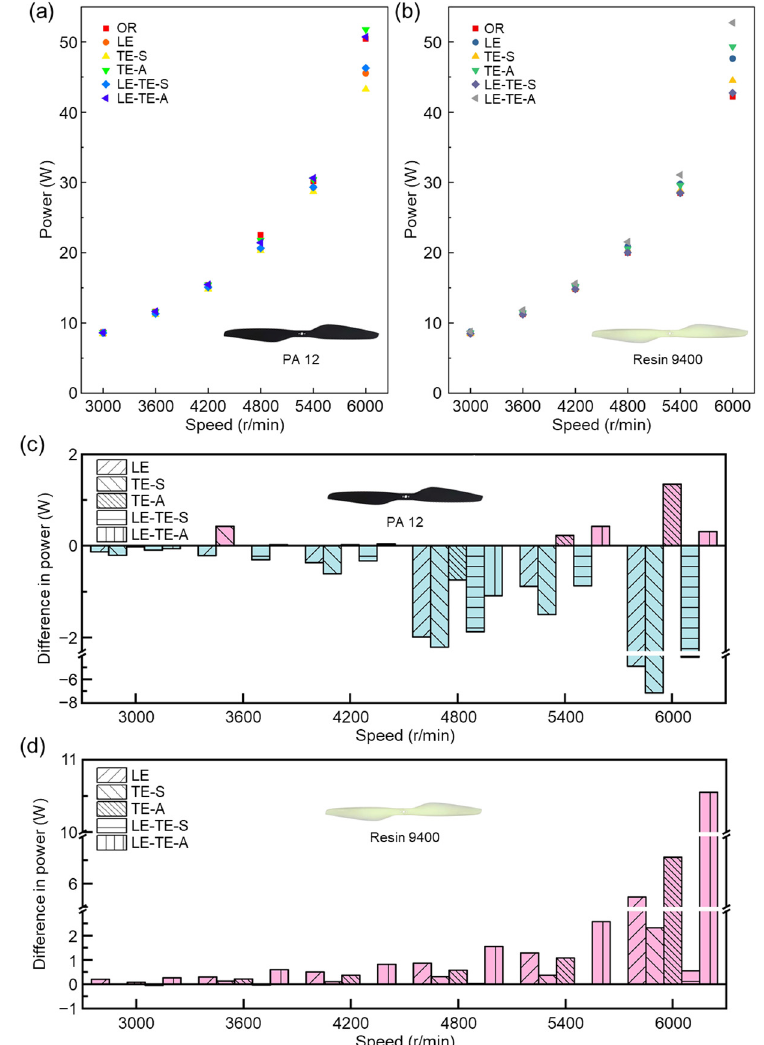
Figure 10. Power comparison of different rotors at various speeds. ( a ) Power consumption of bionic rotors with PA 12; ( b ) Power consumption of bionic rotors with Resin 9400; ( c ) Comparison of power consumption between bionic rotors with PA 12; ( d ) Comparison of power consumption between bionic rotors with Resin 9400. The power consumption of the OR rotor was taken as a reference value (0 W). Under the same conditions, the increase in power was positive and the decrease in power was negative.